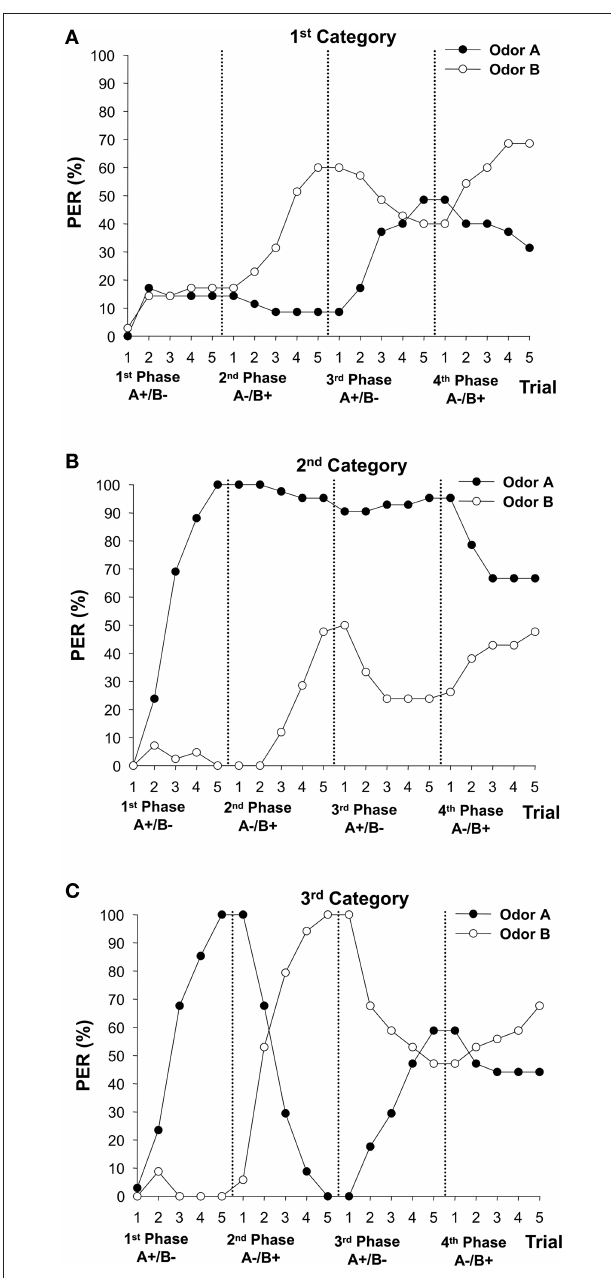
Figure 4 | Conditioned responses during multiple reversal learning in three categories of honeybees. Proboscis extension responses (% PER) to odors A and B during four consecutive differential conditioning phases. Categories were defined by determining individual success in solving the 1st and the 2nd conditioning phases. The criterion used to define success in solving each phase was the presence of a dual correct response in the last (fifth) trial, i.e., PER to the CS + and absence of PER to the CS − . (A) First category ( n = 35 bees) included individuals that were not able to solve the very first discrimination of the 1st phase (A + vs. B − ). (B) Second category ( n = 42 bees) included individuals that mastered the very first discrimination, but were unable to solve the subsequent reversal discrimination of the 2nd phase (A − vs. B + ). (C) Third category ( n = 34 bees) included individuals that solved the discriminations of the 1st and the 2nd phase, for which, therefore, the question of success in further reversal learning (3rd and 4th phases) was